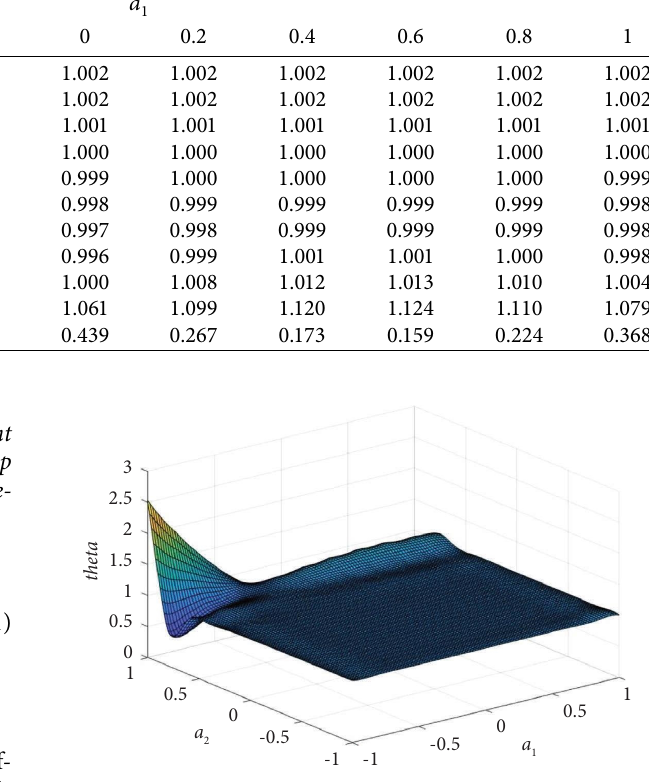
Figure 2: Te critical discount varies with relationship